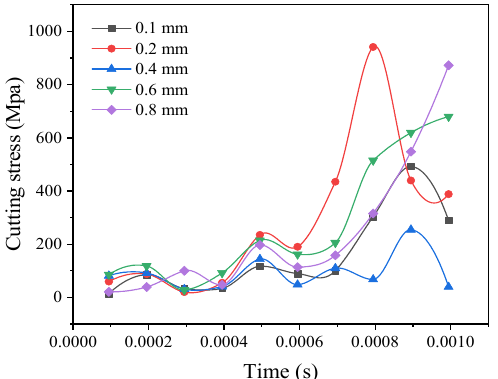
Figure 11. Comparison curve of the cutting stress with different corner radii.